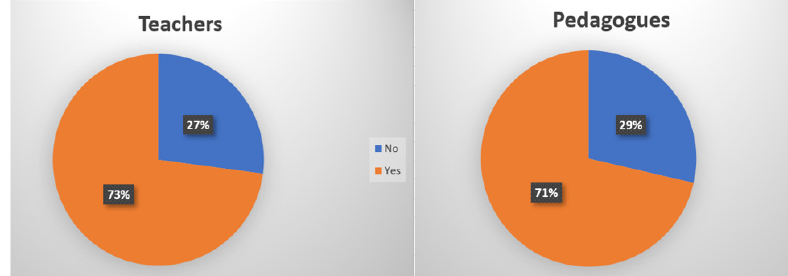
Figure 1. Usage of quizzes in online teaching by teachers and pedagogues.